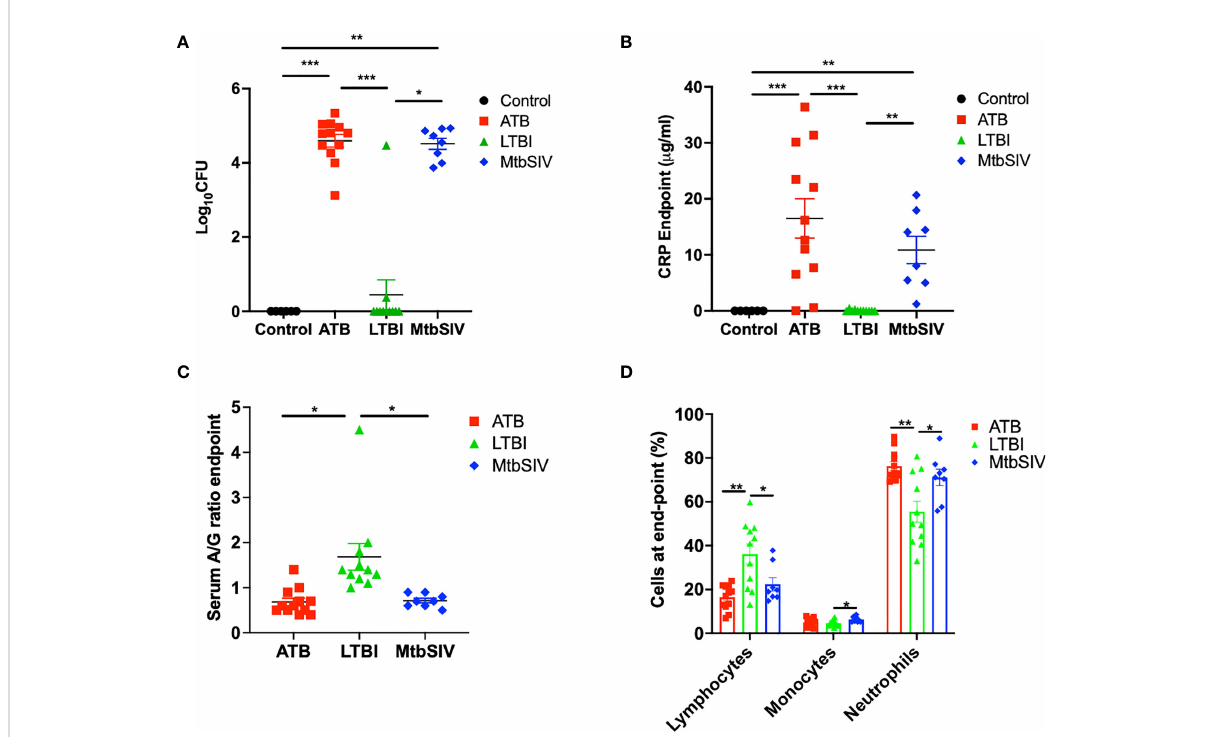
FIGURE 1 Clinical metrics at endpoint. At necropsy colony forming units(log 10 ) are measured in the lung (A) and serum C-reactive protein (B) , serum albumin-to-globulin ratio (C) , percentage of cells (D) are measured in the periphery through the blood. For CFU (A) and CRP (B) we compared all four cohorts, control (black), ATB(red), LTBI (green), and Mtb /SIV (blue). Serum albumin and globin (C) and cells in the periphery measured through fl ow (D) cytometry. Data is shown for control (n=6), ATB (n=12), LTBI (n=11), and Mtb /SIV (n=8). Error bars represent Mean ± SEM. (*P value of ≤ 0.01; **P value of ≤ 0.001; ***P value of